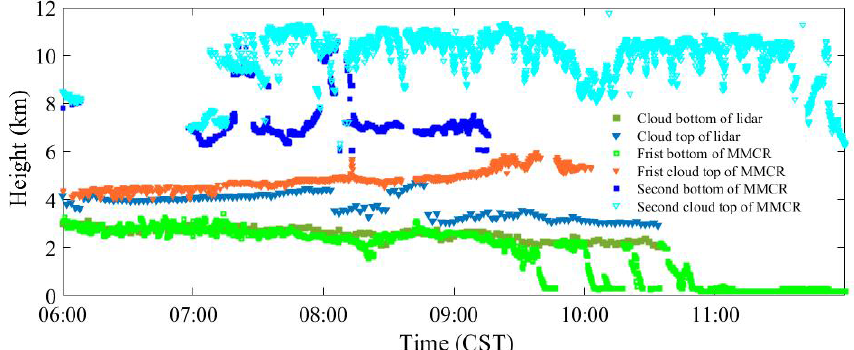
Figure 13. Cloud boundary detected by the lidar and MMCR on 10 March 2021.